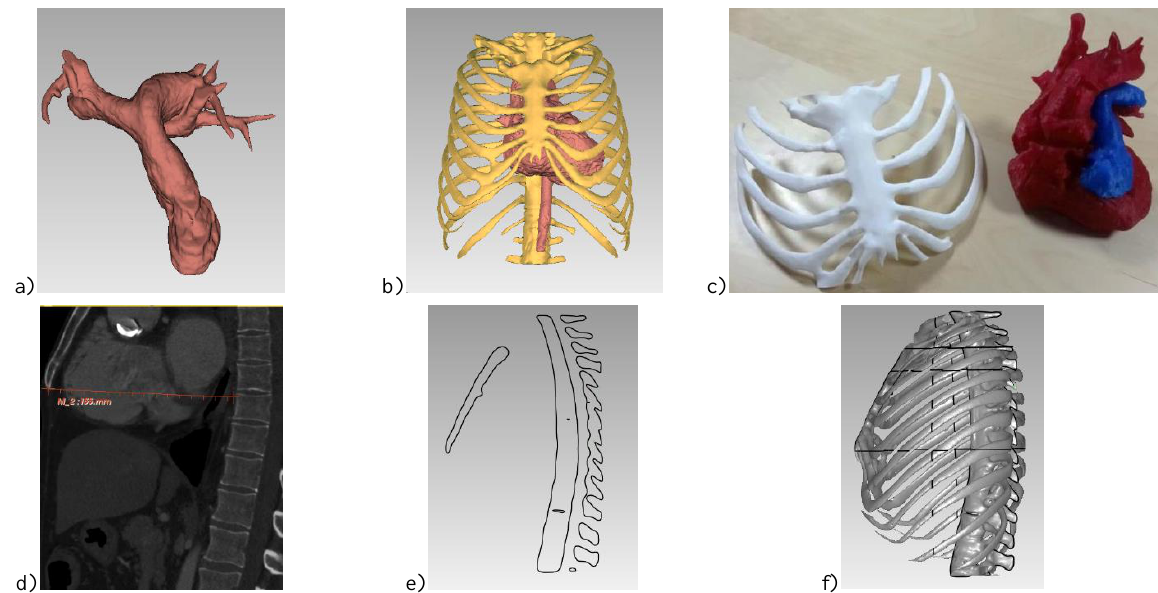
Figure 6. Surface mesh model of pulmonary artery (a), chest bones and heart with aorta (b) and their physical replicas (c). Model check trough measurements taken on the original slices (d) and on corresponding sections on the mesh model (e and